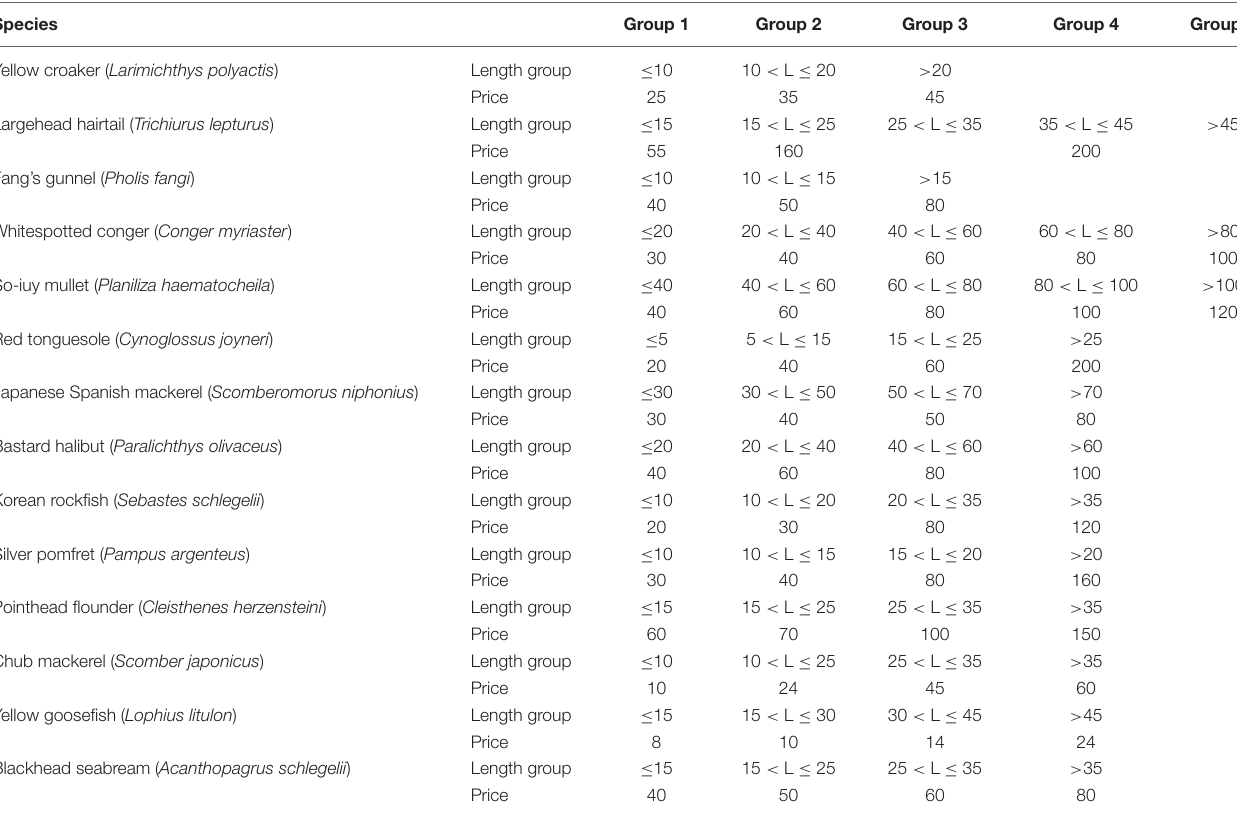
TABLE 3 | Fish price for different length class in China’s aquatic products market. Species